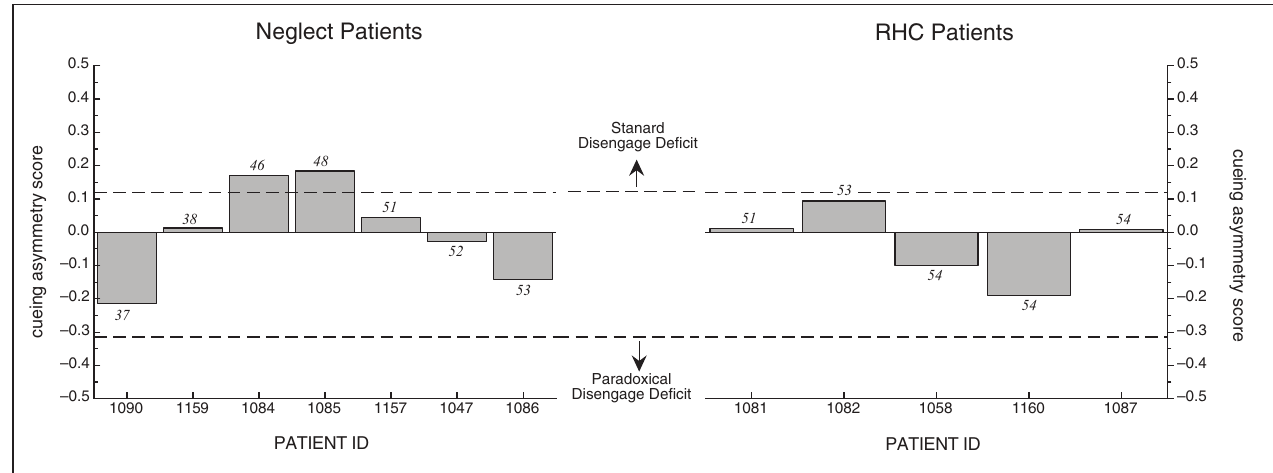
FIGURE 5 | Cueing asymmetry scores in the TOJ task for Neglect patients (left graph) and RHC patients (right graph) plotted in order of each patient’s BIT Star Cancellation score (see text for details). Dotted lines represent + / − 2SD of mean OHC cueing asymmetry score.